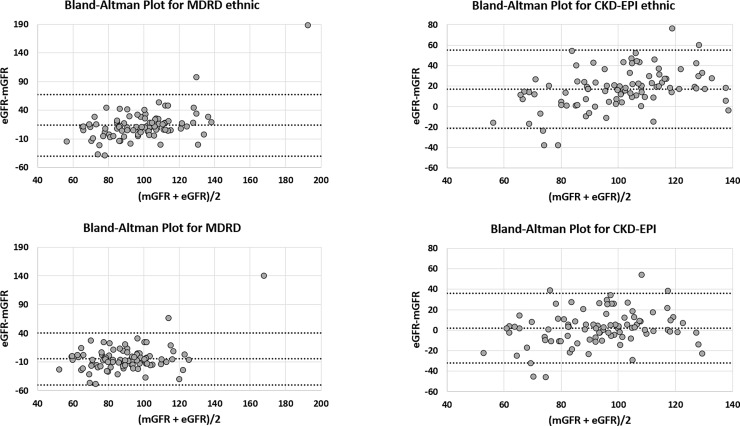
Bland and Altman analysis between mGFR and creatinine-based equations (with and without the ethnic factor).All values are expressed in mL/min/1.73m2. CKD-EPI SCr: Chronic Kidney Disease-Epidemiology Collaboration equation based on serum creatinine only, with ethnic factor; CKD-EPI SCr nef: CKD-EPI without ethnic factor. MDRD: Modification of Diet in Renal Disease study equation with ethnic factor; MDRD nef: MDRD without ethnic factor. The central line represents the mean difference between measured and estimated GFR, whereas the upper and lower lines represent the limits of agreement (mean difference ± 2SD).